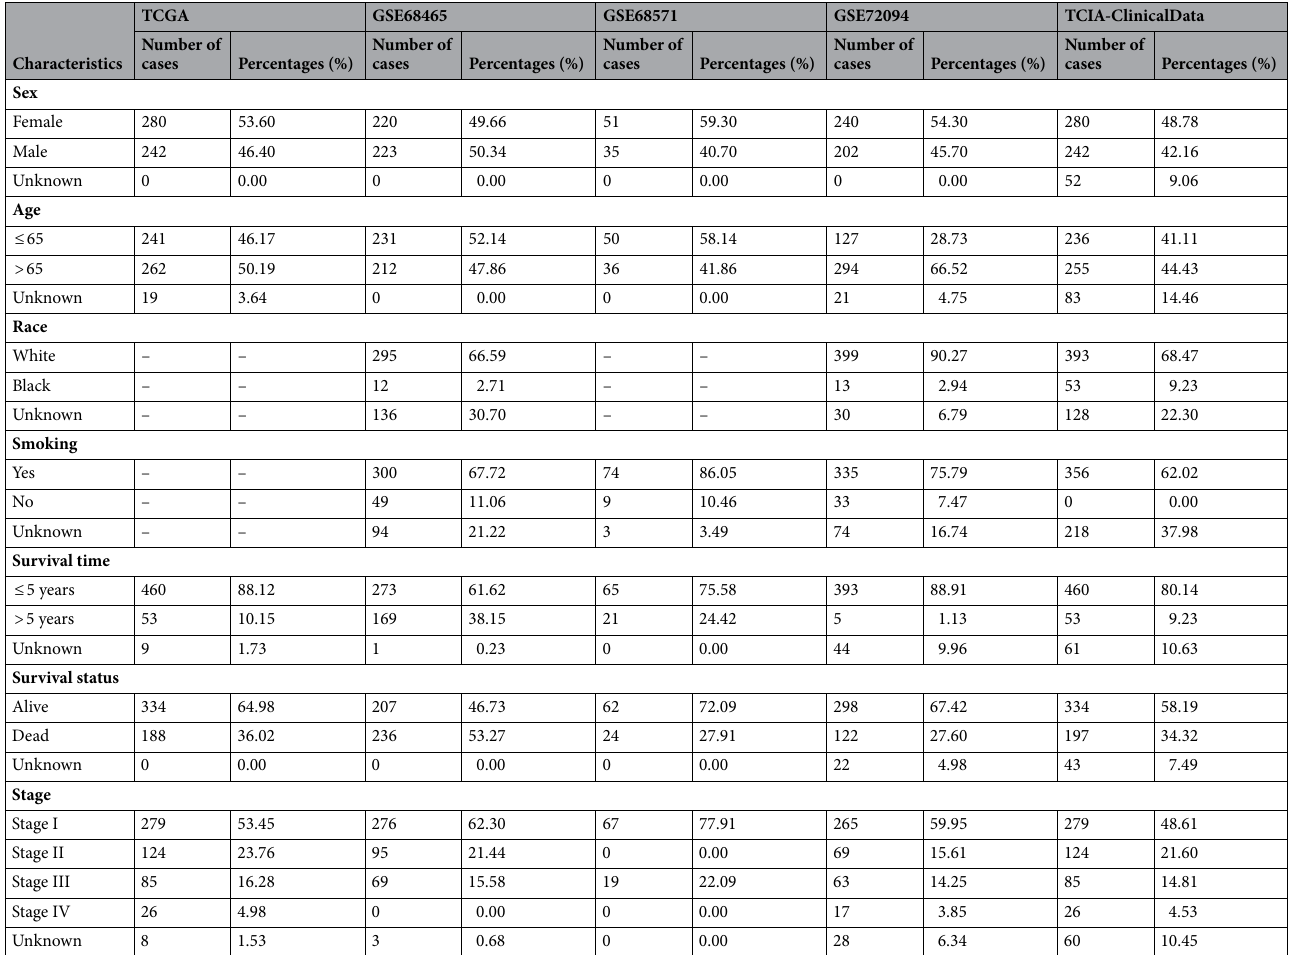
Table 5. The baseline information of LUAD patients on the datasets of our